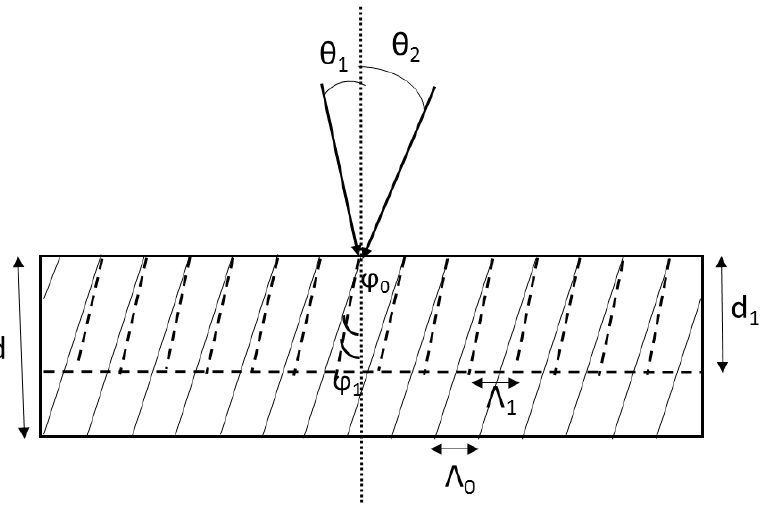
Figure 4. Schematic diagram of the shrinkage process for transmitting holographic